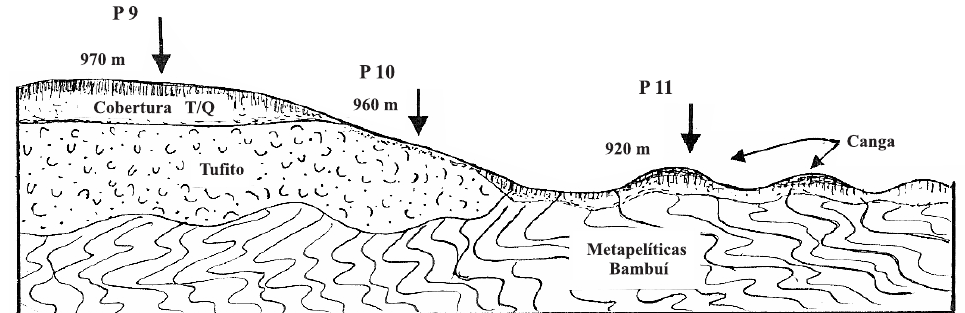
Figura 3. Perfil geológico esquemático da topolitossequência Coromandel (T3) e posições dos respectivos